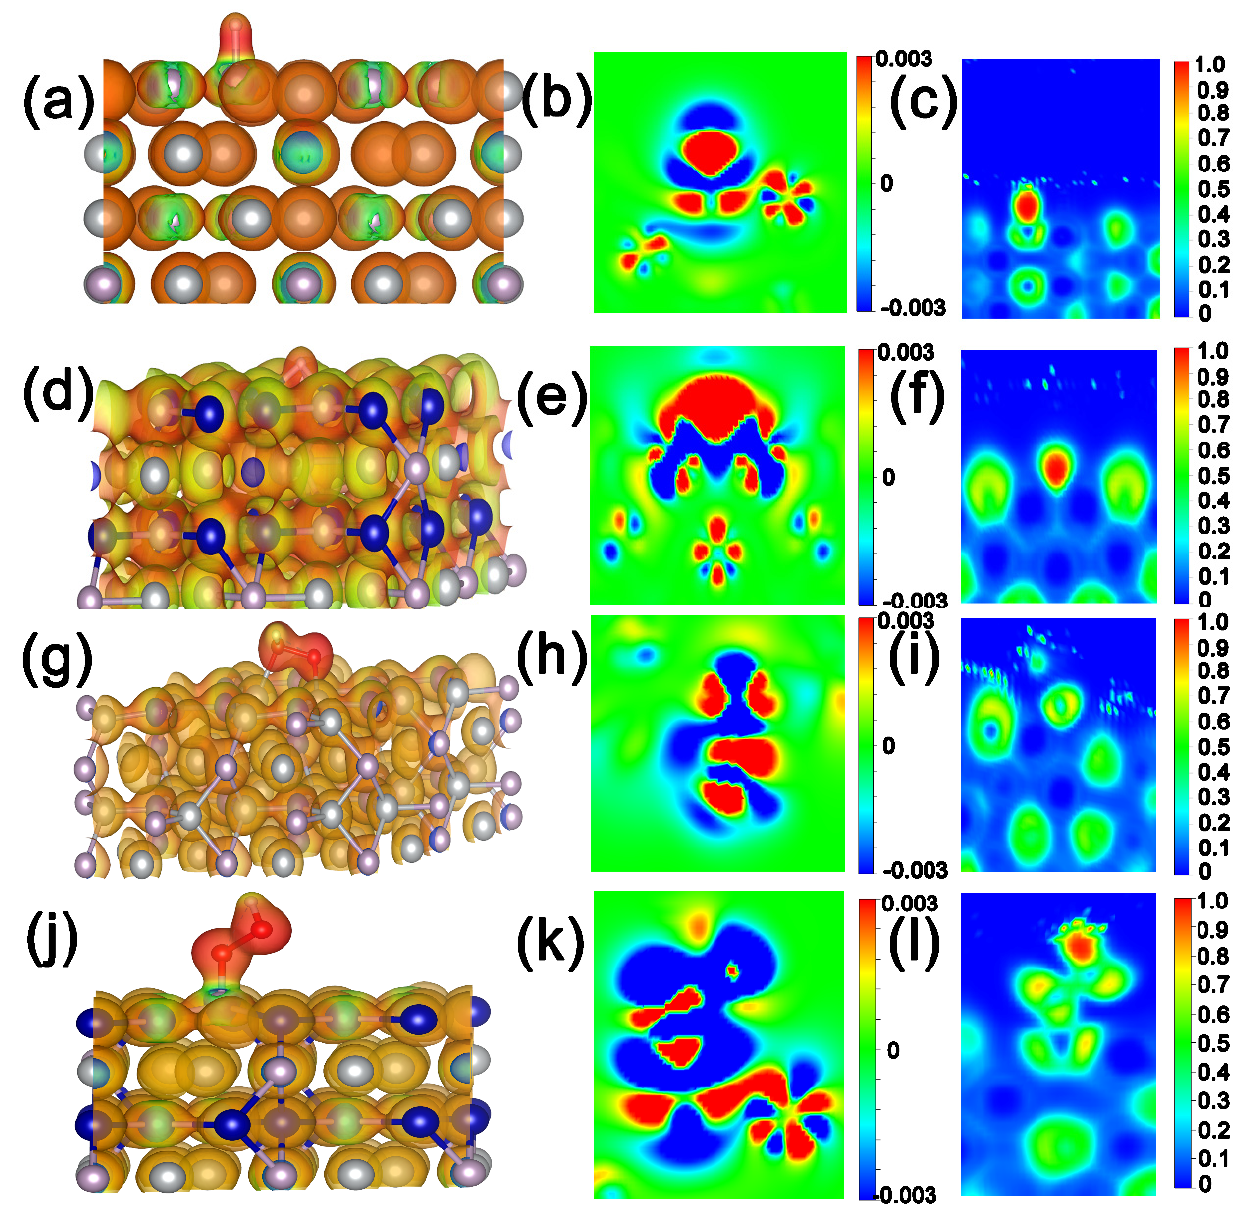
Figure 9. Electrostatic potential distribution after adsorption of H* on the ( a ) Ni 2 P and ( d ) CoNiP surface. The corresponding cross section of charge density difference of ( b ) Ni 2 P, ( e ) CoNiP and ( d ) Ni 2 P. The corresponding electron localization function (ELF) of ( c ) Ni 2 P and ( f ) CoNiP. Electrostatic potential distribution after adsorption of *OOH on the ( g ) Ni 2 P and ( j ) CoNiP surface. The corresponding cross section of charge density difference of ( h ) Ni 2 P, ( k ) CoNiP. The corresponding electron localization function (ELF) of ( i ) Ni 2 P and ( l ) CoNiP.